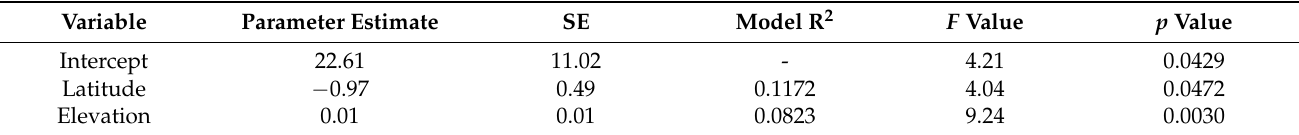
Table 3. Stepwise regression of surface topology and physicochemical property to total nitrogen stock in Udults soils at the depth of 80–100 cm for a secondary forest and Eucalypt ( Eucalyptus obliqua L’H é r.), Litchi ( Litchi chinensis Sonn.,